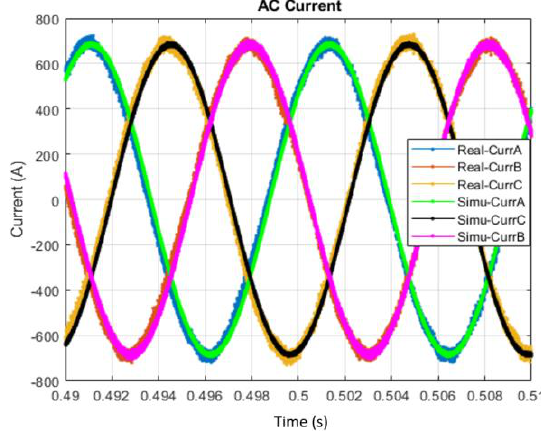
Figure 20. Case 1: speed = 2760 RPM and torque = 105 Nm.